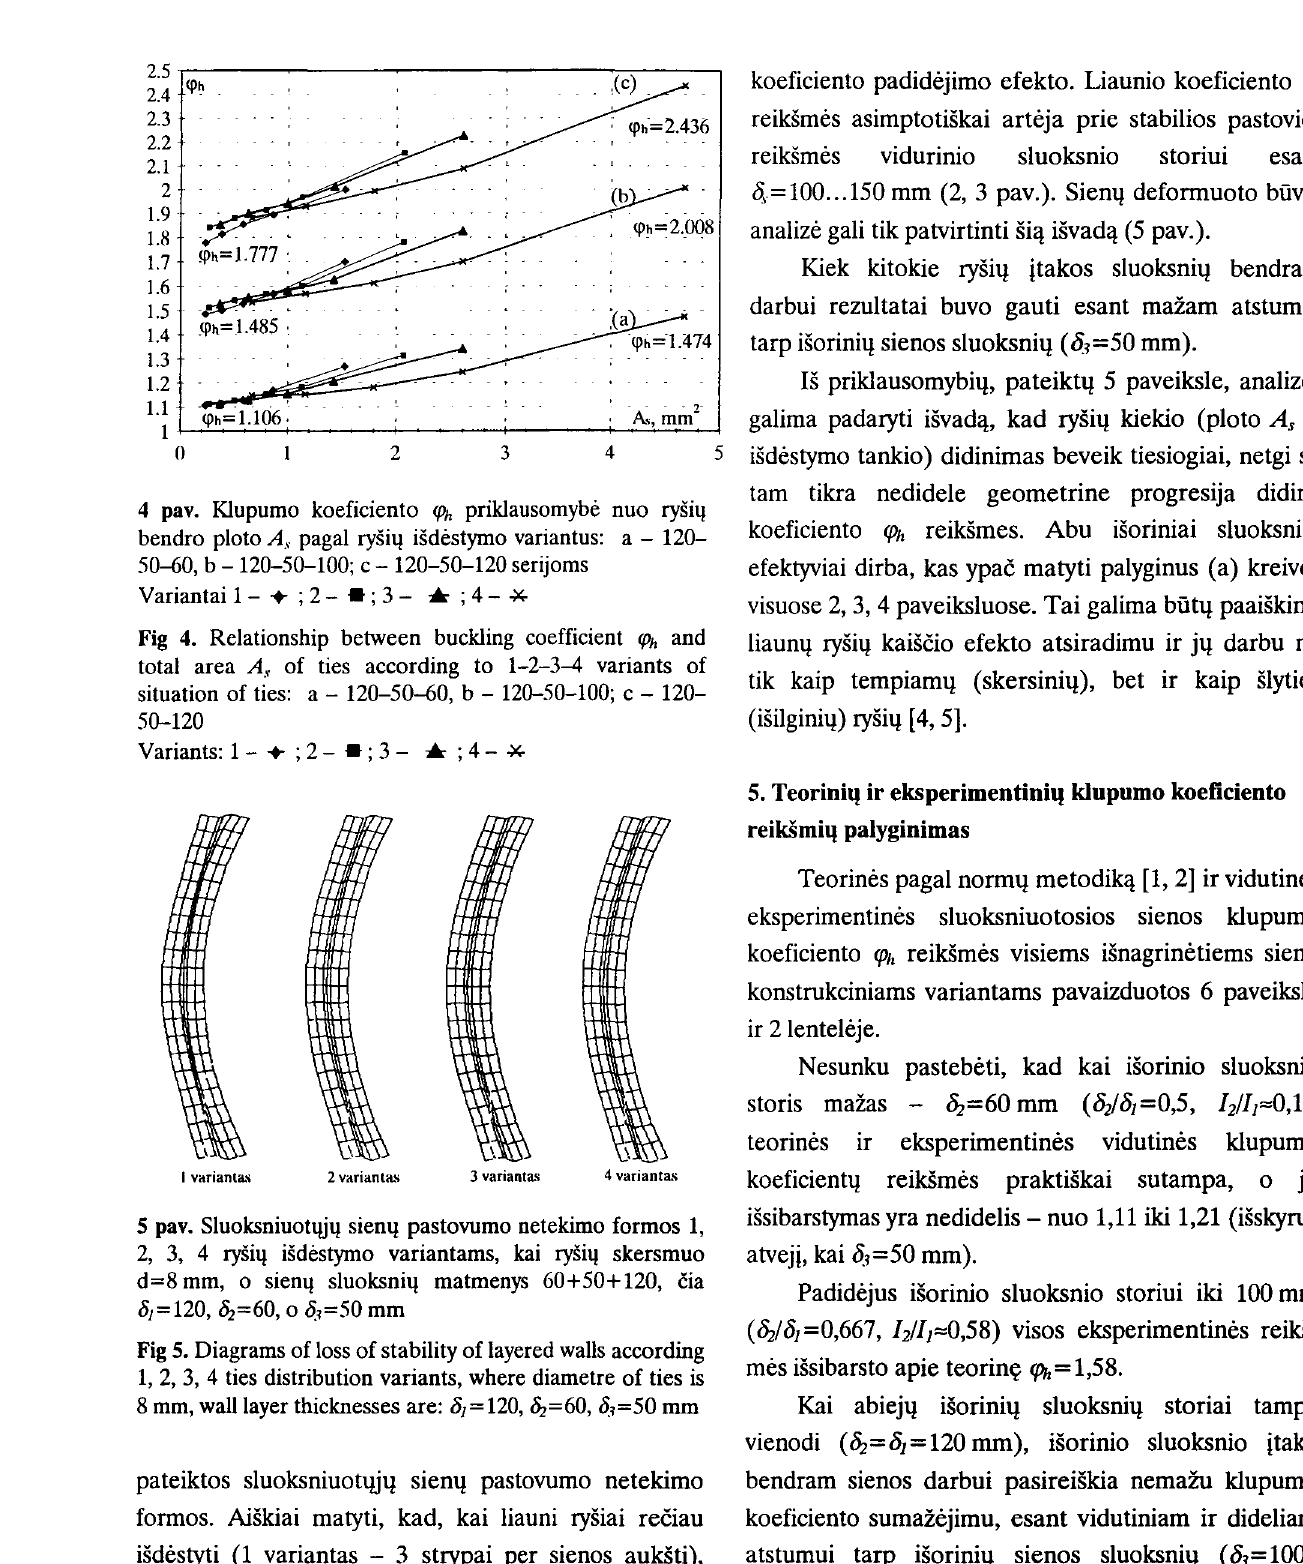
Fig 5. Diagrams of loss of stability of layered walls according 1, 2, 3, 4 ties distribution variants, where diametre of ties is 8 mm, wall layer thicknesses are: 8 =120, ~=60, O:l=50 mm 1 pateiktos sluoksniuotqjq sienq pastovumo netekimo formos. Aiskiai matyti, kad, kai liauni rysiai